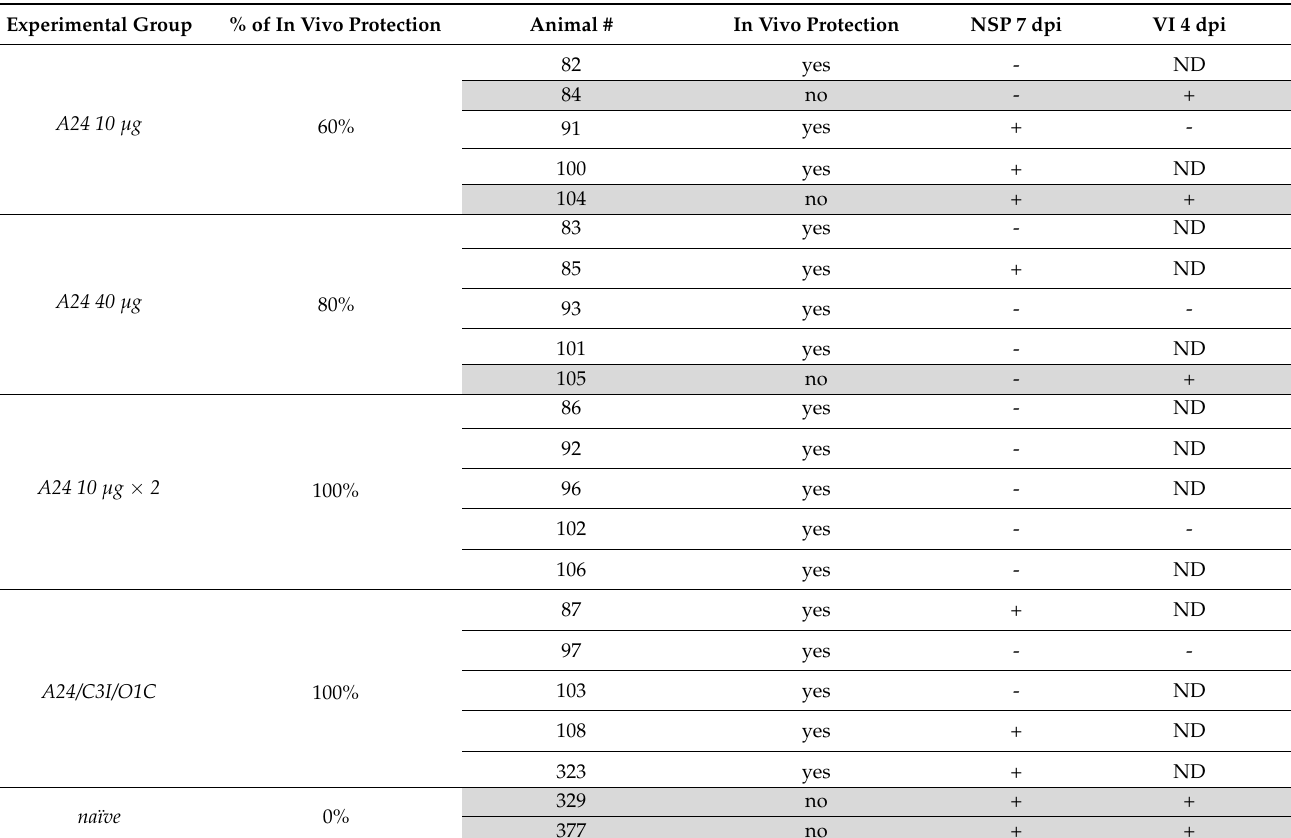
Table 1. Percentage of protection and viral replication in FMD vaccinated animals after heterologous challenge. The performance in the in vivo challenge assay is expressed as the percentage of protected animals in each experimental group. Rows represent individual animals; shaded rows correspond to non-protected animals. Viral replication after experimental infection was assessed from serum samples taken at 7 dpi through the detection of antibodies against FMDV non-structural proteins (NSP). Results express the presence (+) or absence (-) of anti-FMDV NSP antibodies. FMDV isolation (VI) was performed in serum samples obtained at 4 dpi from animals with clinical FMD. The development (+) or the absence (-) of cytopathic effect was assayed on BHK-21 cell cultures (ND: